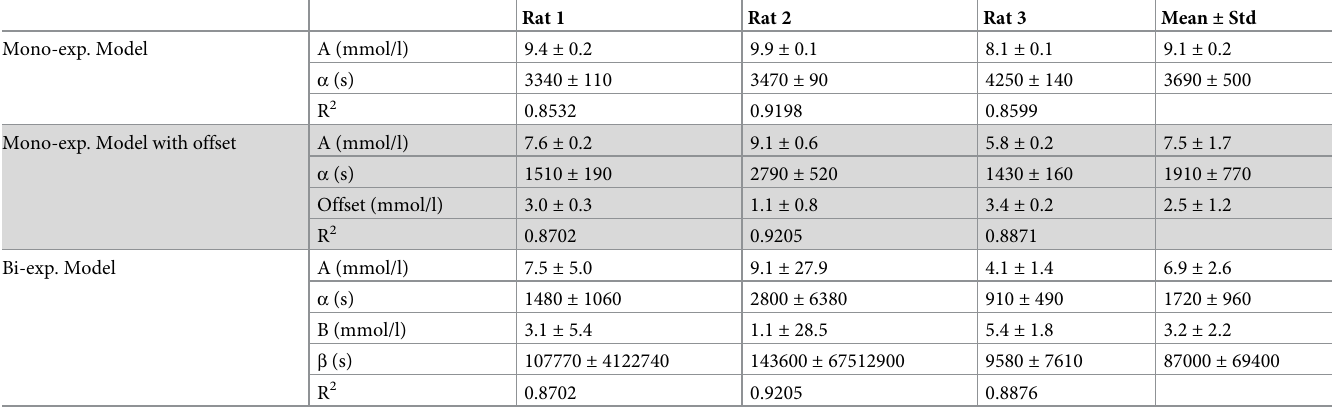
Table 1. Washout rates of OMG in